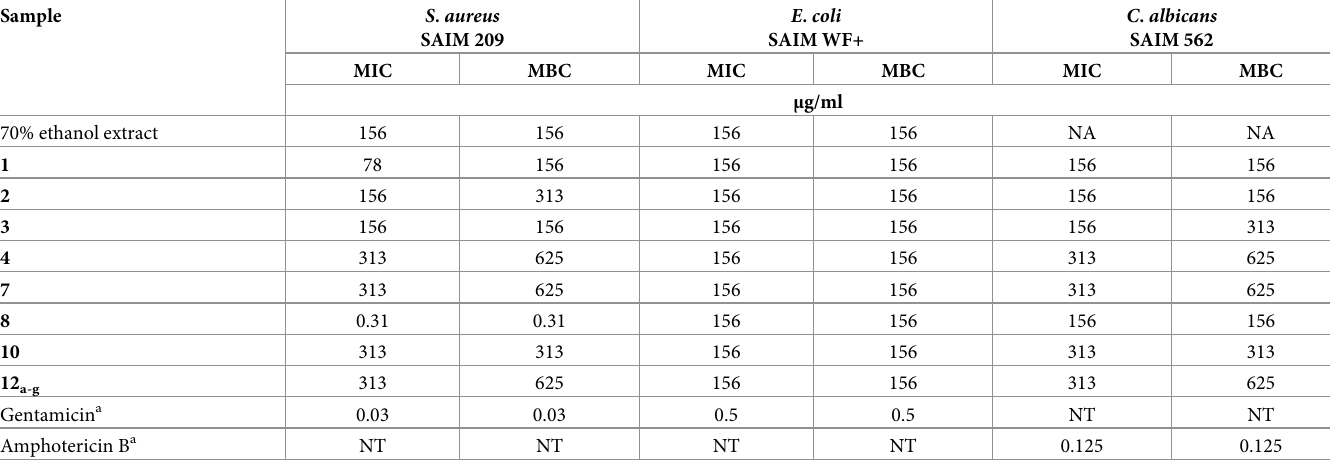
Table 3. Antimicrobial activities of 70% ethanol extract and isolated